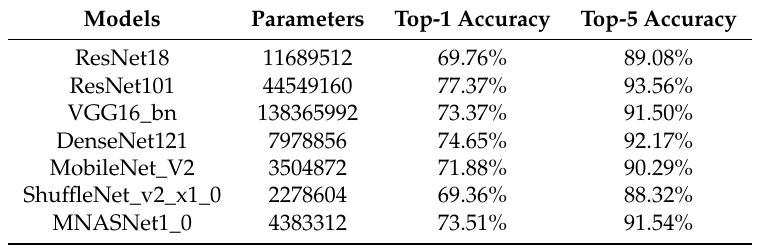
Table 1. The number of parameters of the models used and their accuracy on